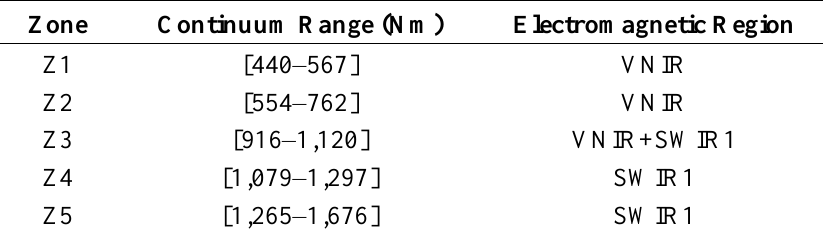
Table 5. Continuum removal zones considered in this study.